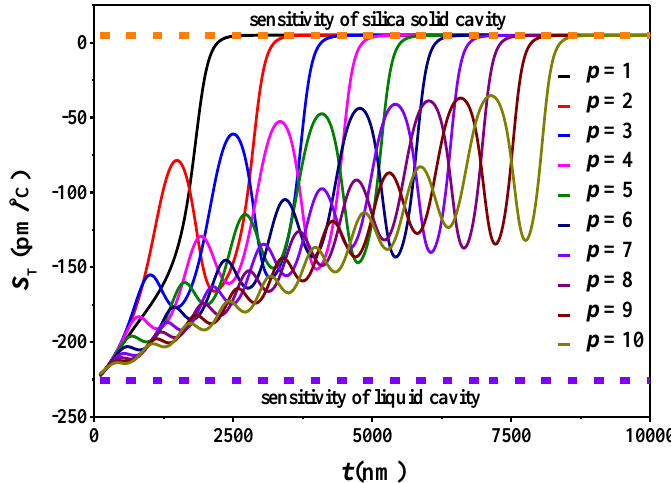
Figure 4. The sensitivity as a function of the shell thickness for the p = 1–10 WGM. The simulation parameters are the same as those in Figure 1.